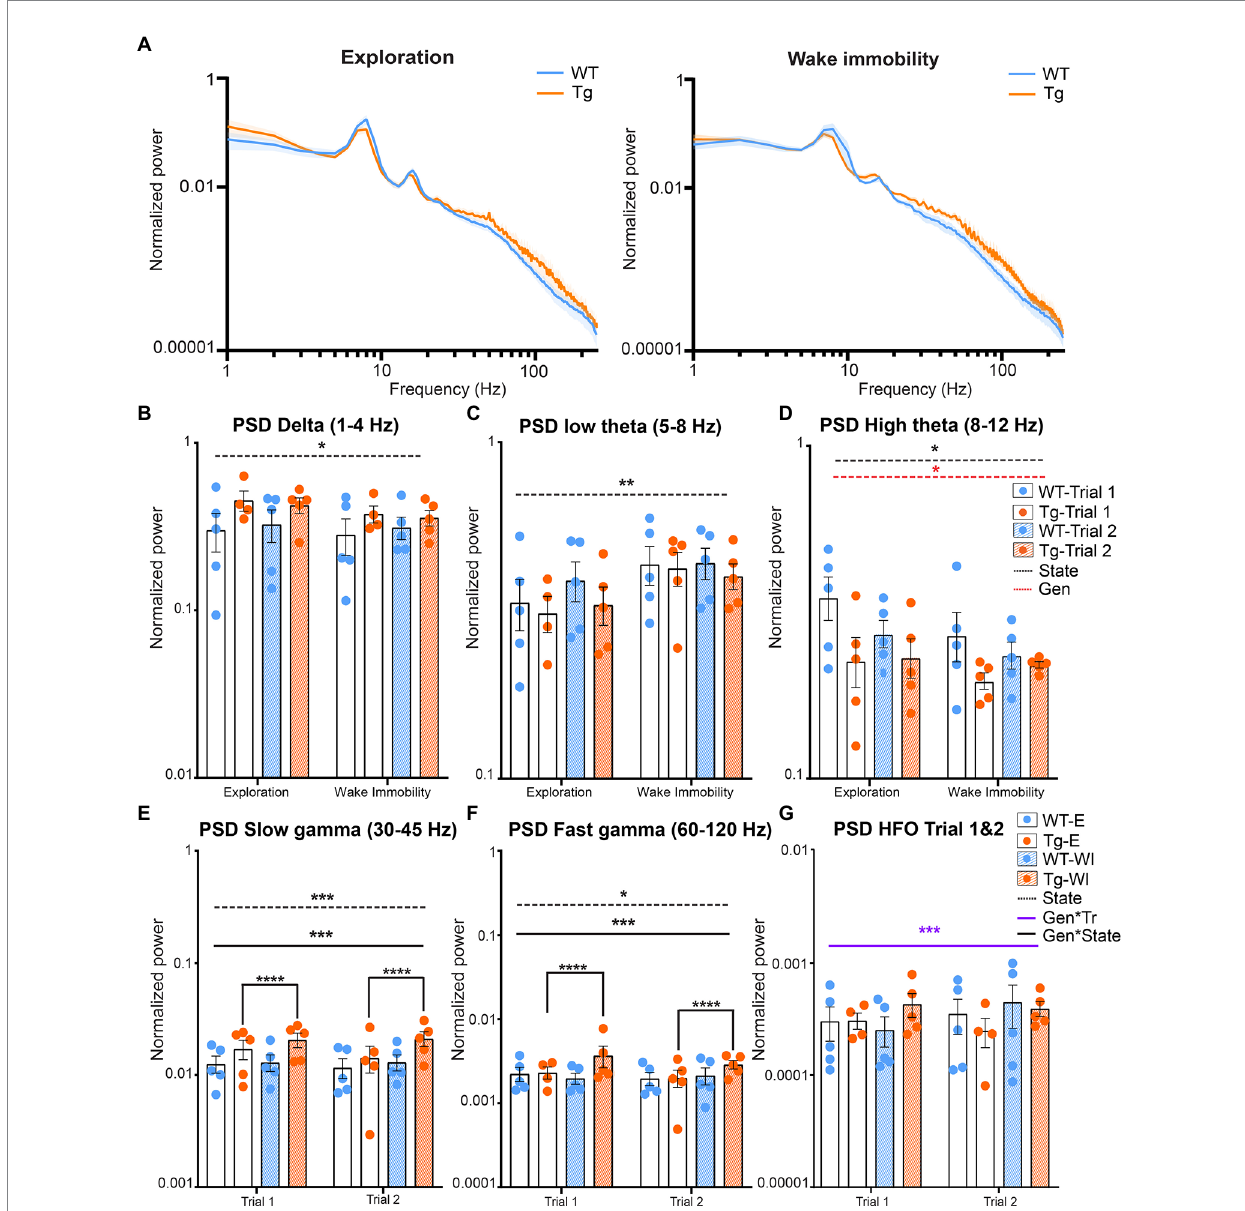
FIGURE 2 Power during explorative and wake immobility behavior in TgF344-AD rats and wildtype littermates. (A) Mean normalized power spectra during explorative behavior (left) and wake immobility (right) at trial 1. Graphs show the mean power across groups. Shading indicates the SEM across the groups. (B) Averaged normalized power (mean ± SEM) of the delta oscillations at trial 1 and trial 2 during exploration and wake immobility (WI). (C) Averaged normalized power (mean ± SEM) of the low theta oscillations at trial 1 and trial 2 during exploration and wake immobility (WI). (D) Averaged normalized power (mean ± SEM) of the high theta oscillations at trial 1 and trial 2 during exploration and wake immobility (WI). (E) Averaged normalized power (mean ± SEM) of slow gamma oscillations during exploration (E) and wake immobility (WI) across trials. (F) Averaged normalized power (mean ± SEM) of fast gamma oscillations during exploration (E) and wake immobility (WI) across trials. (G) Averaged normalized power (mean ± SEM) of high-frequency oscillations (HFO) during exploration (E) and wake immobility (WI) across trials. PSD, power spectral density, * p ≤ 0.05, ** p ≤ 0.01, *** p ≤ 0.001, **** q ≤